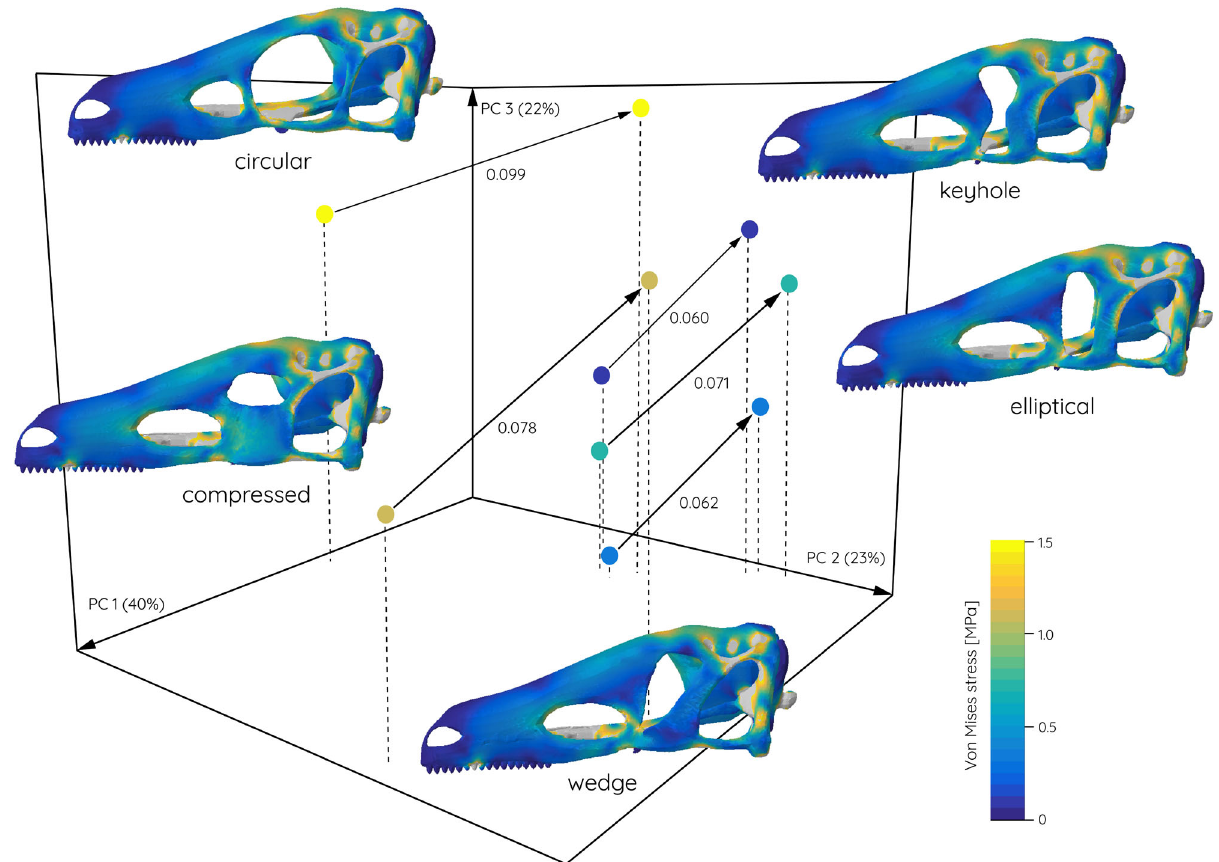
Fig. 7 Three-dimensional deformation space. Position of hypothetical skull models visualised for PCs 1-3. Distance between undeformed and deformed models indicated by arrows and calculated Euclidean distances. Von Mises stress contour plots for each model show in undeformed condition.